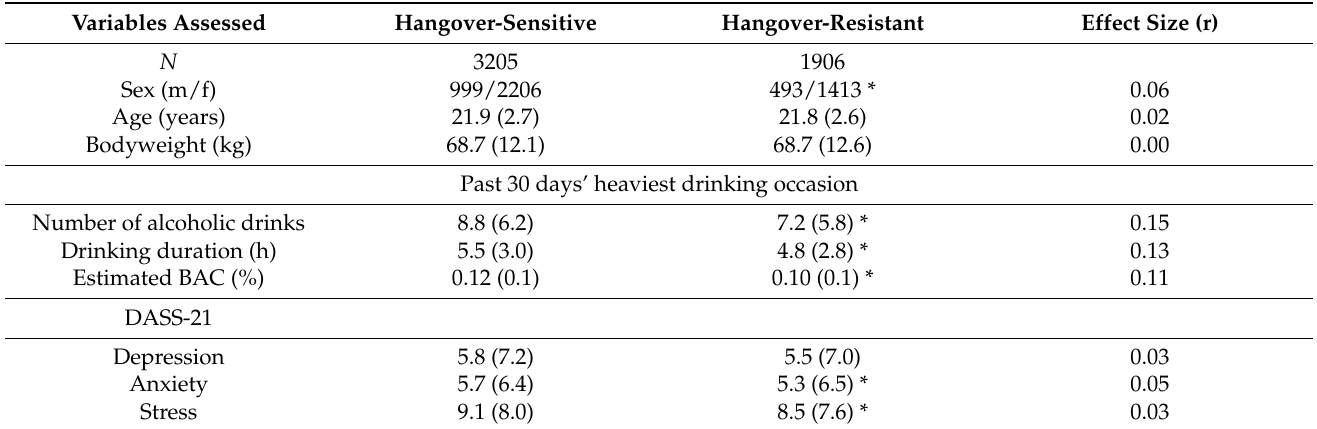
Table 2. Demographics and study outcomes of hangover-sensitive and -resistant